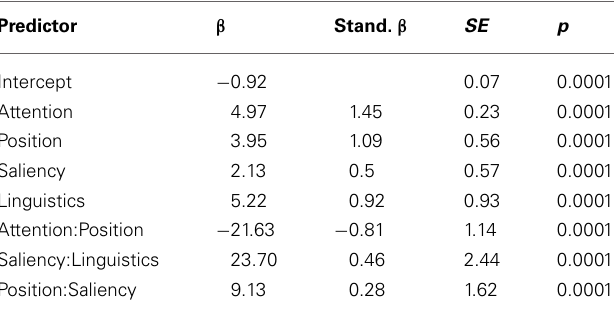
Table 8 | Coefficients for the mixed effects model analysis of Mention. Predictor β Stand. β